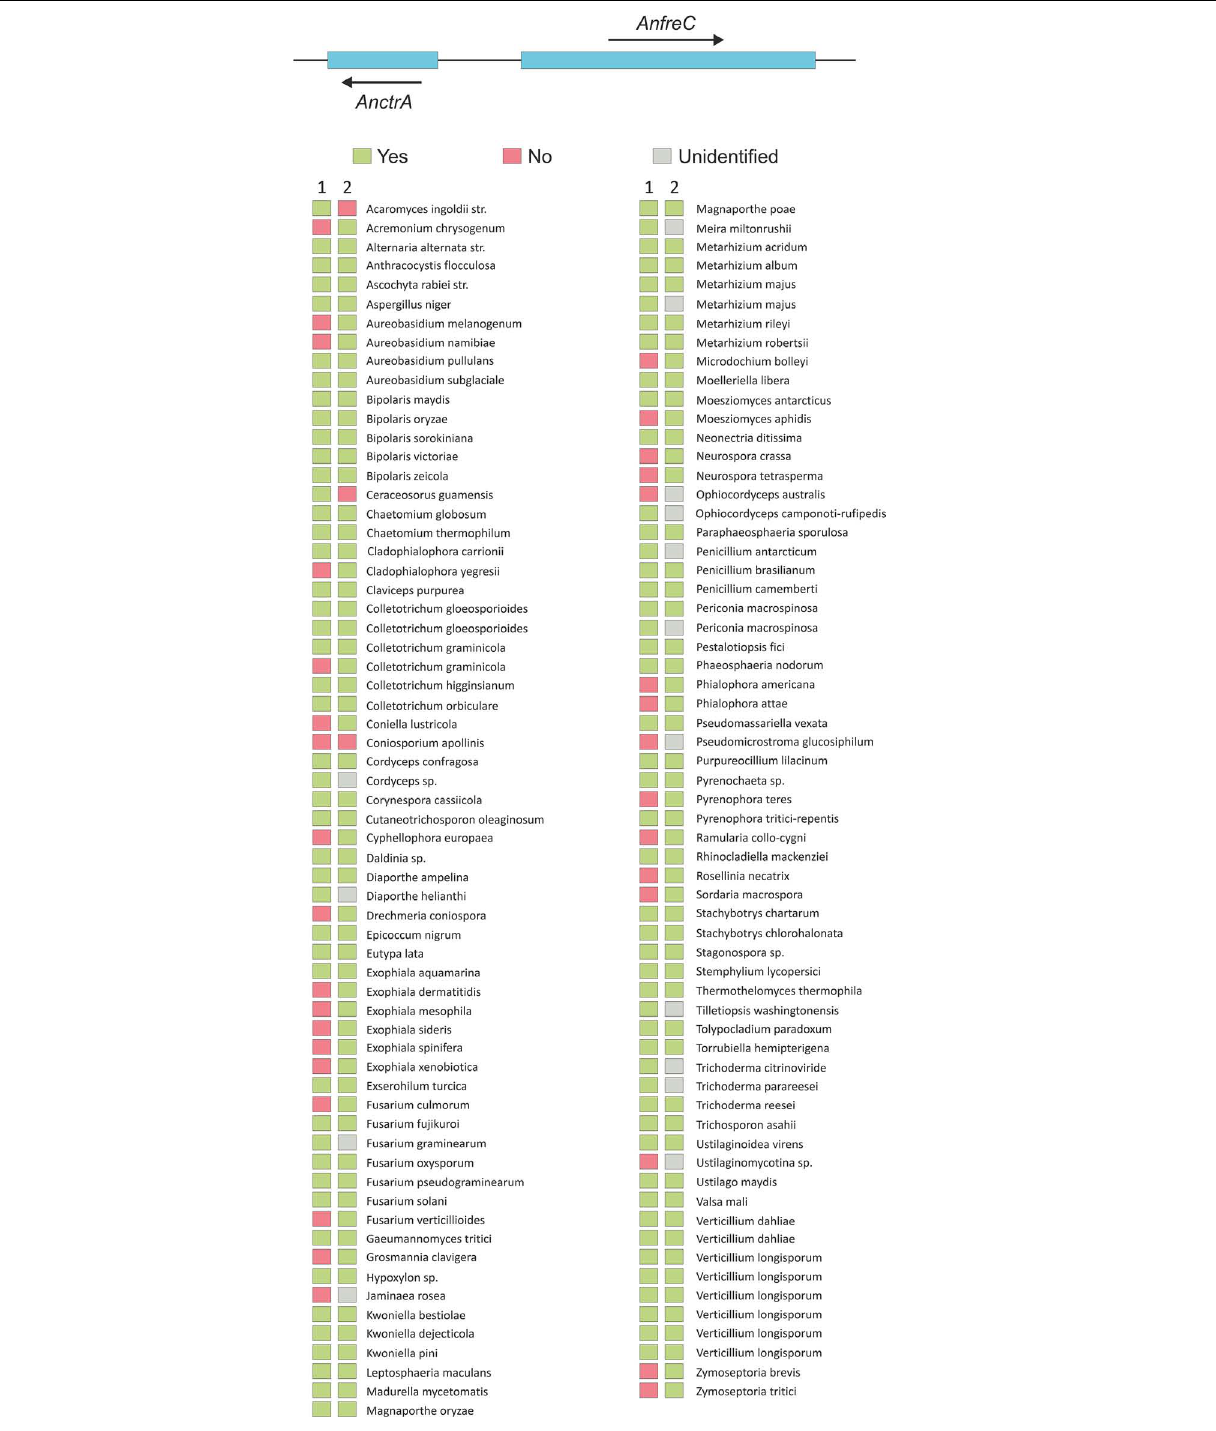
Frontiers in Microbiology |